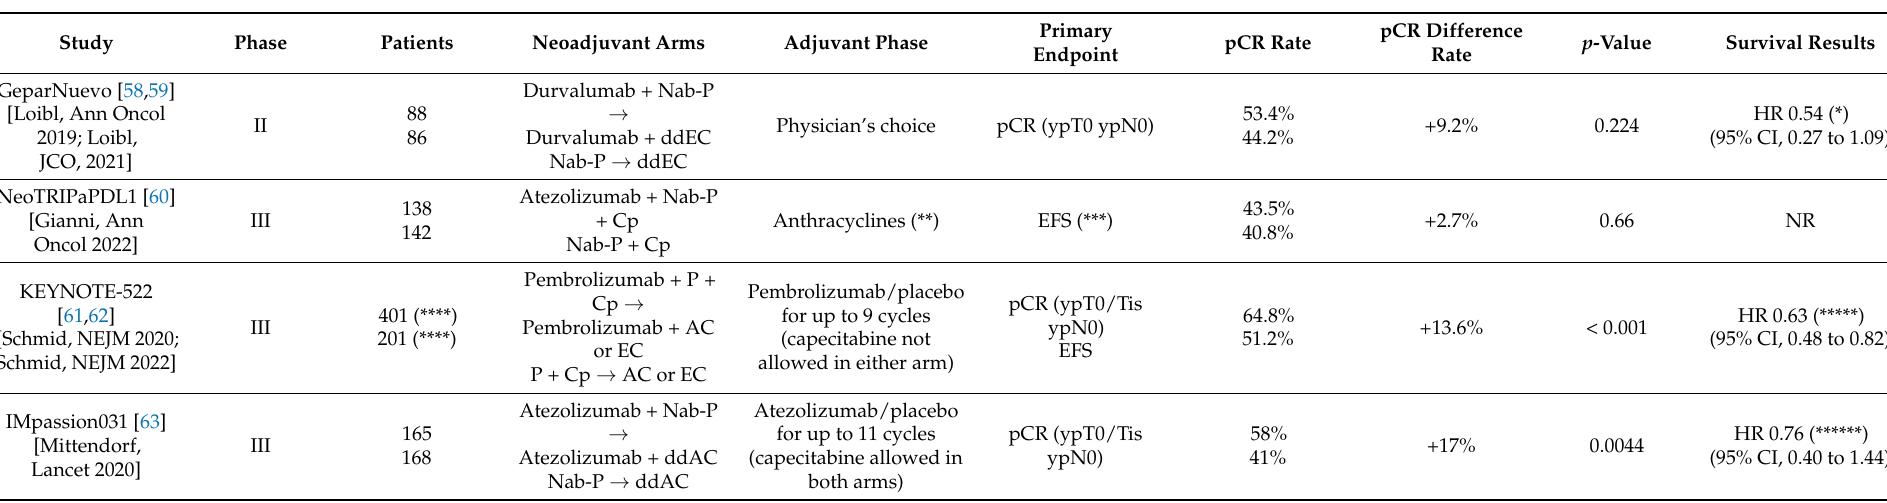
Table 1. Neoadjuvant randomized trials exploring the addition of immune checkpoint inhibitors in triple-negative breast